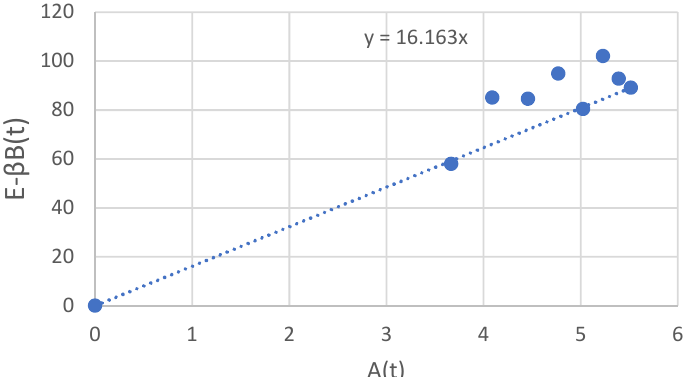
Figure 3. Determination of α . The slope of the line was α (U/g), the growth-associated constant for laccase formation. β , the biomass-associated constant for laccase formation, was equal to 0.497 U/g/d).